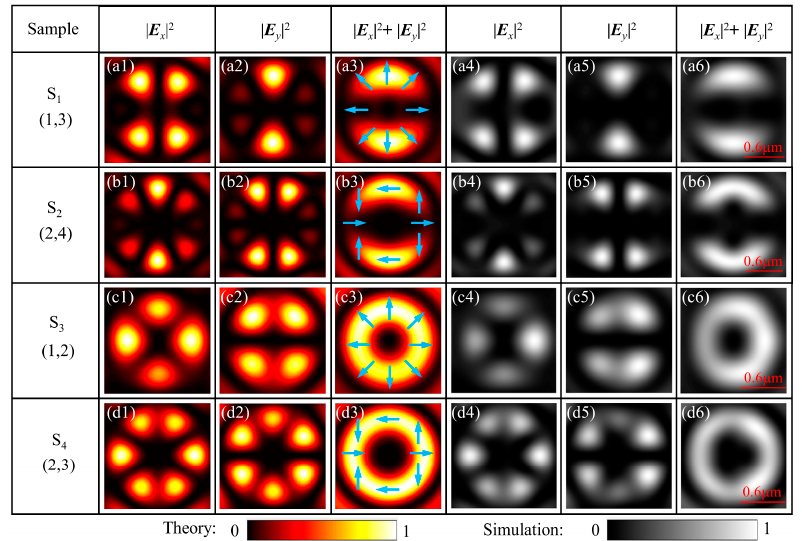
Figure 3. The theoretical and simulation results for the intensities of the x - and y - components and total intensities | E x | 2 , | E y | 2 and | E x | 2 + | E y | 2 of the superimposed VBs with equal doughnuts for the samples S 1 , S 2 , S 3 and S 4 , respectively.